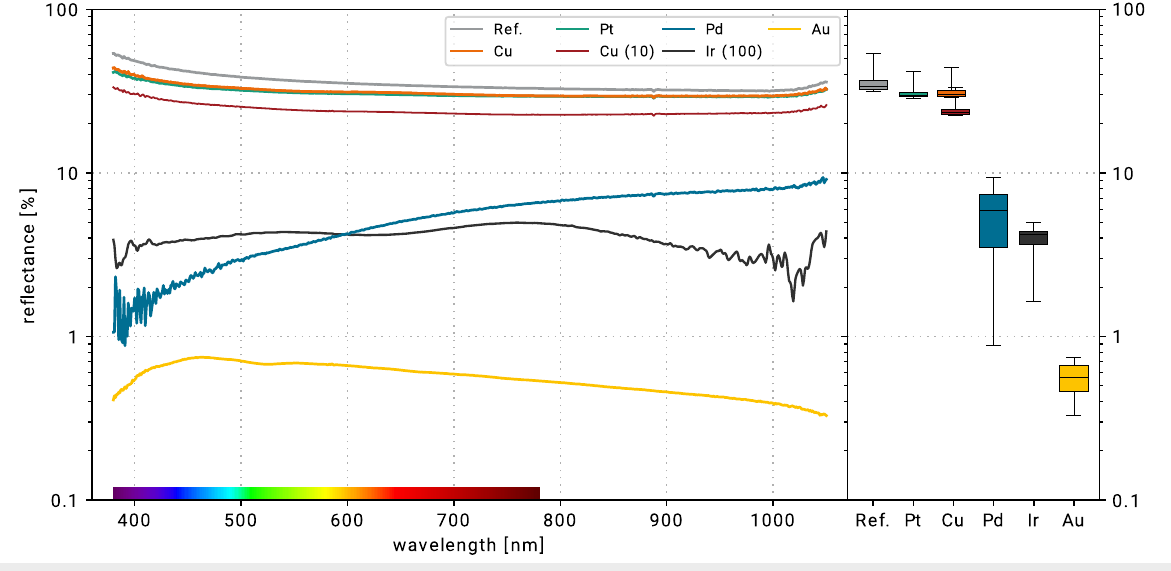
Figure 10: Reflectance of fabricated 3D templates, etched with 50 mmol/L H 2 O 2 and 1.73 mol/L HF for 10 min. Additionally, the spectra of a Si refer- ence, of a Cu wafer etched with 10 mmol/L H 2 O 2 , and of a Ir sample etched with 100 mmol/L H 2 O 2 are given.